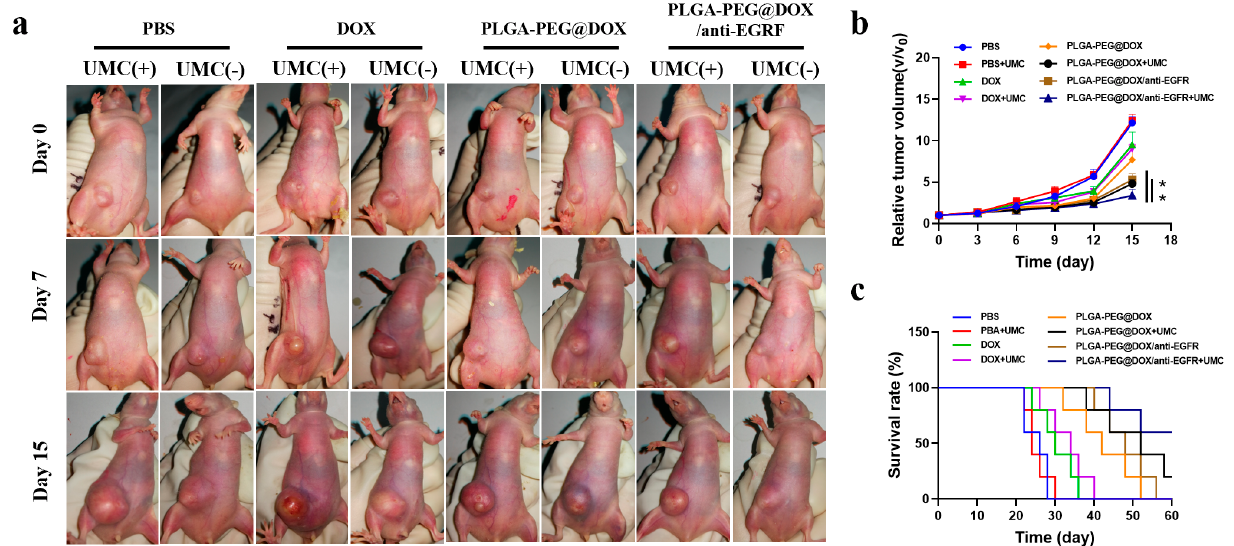
Figure 6. ( a ) Representative images of MBA-MD-468 tumor-bearing mice in the indicated treatment groups. ( b ) Relative tumor volume and ( c ) murine survival rate over time were assessed in the indicated treatment groups. Data are means ± standard deviation ( n = 5). ** p < 0.01. UMC(+) = with ultrasound-mediated cavitation, UMC( − ) = without ultrasound-mediated